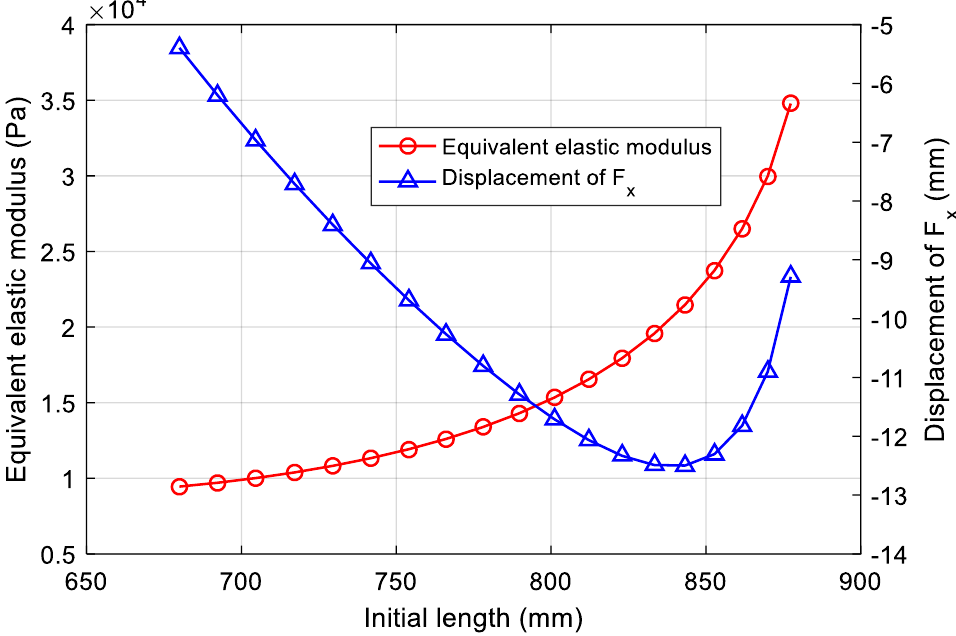
Figure 7. Effect of different initial lengths on the equivalent elastic moduli and the lateral displace- ment of the bionic leg.